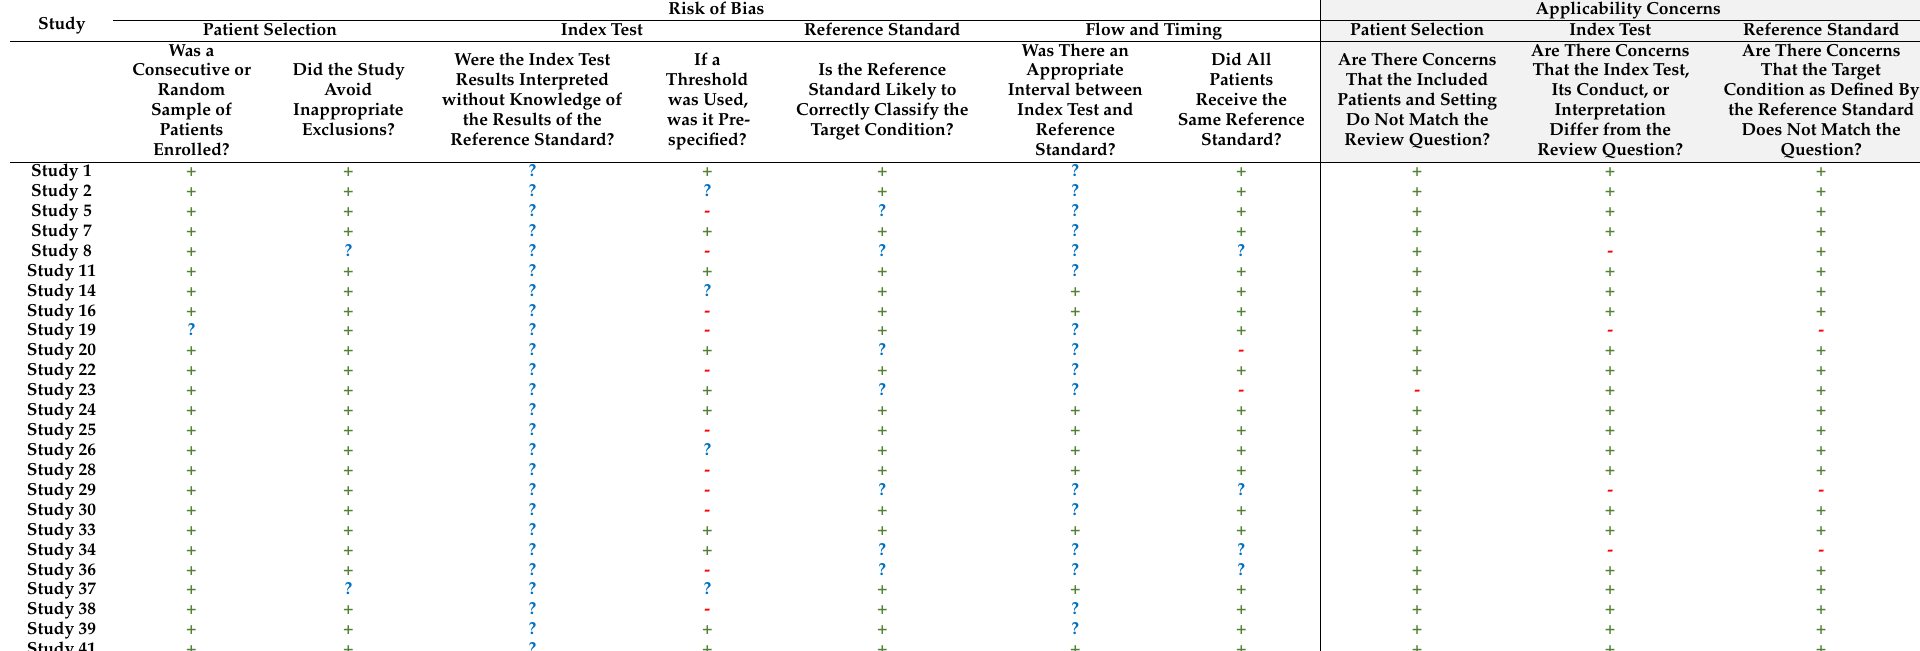
Table 2. Tabular presentation for the QUADAS-2